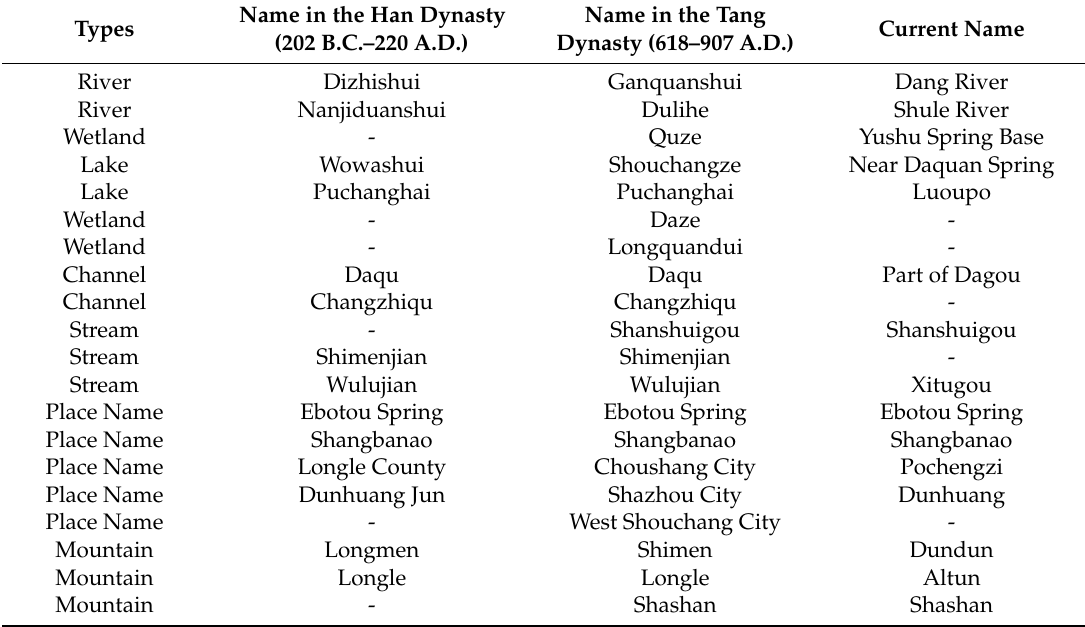
Table A1. Index of the names of the rivers, mountains and locations used in the